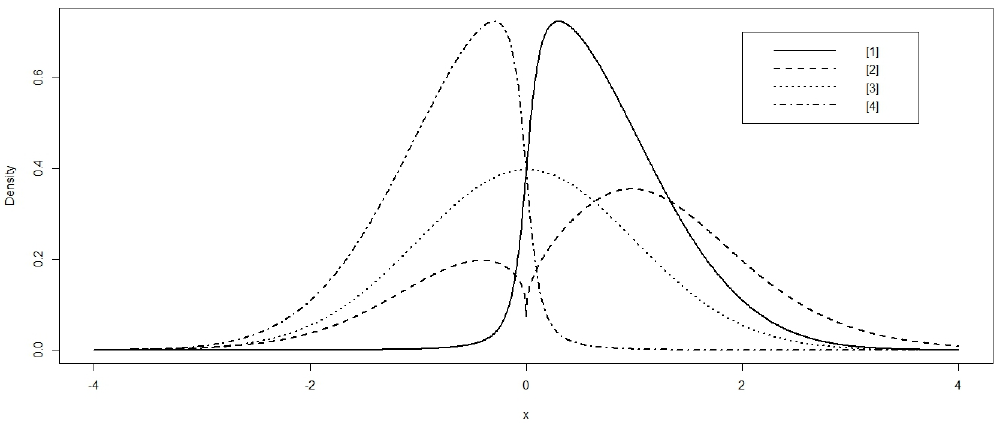
Figure 4. The Skew GL- t distribution using the following parameter values: [1] a = 1.59, b = 0.0727, p = 1.962, v = 2 and c = 10; [2] a = 0.3, b = 0.7, p = 0.4, v = 3 and c = 0.6; [3] a = 1.59, b = 0.0727, p = 1.962, v = 3 and c = 0; [4] a = 1.59, b = 0.0727, p = 1.962, v = 2 and c = −